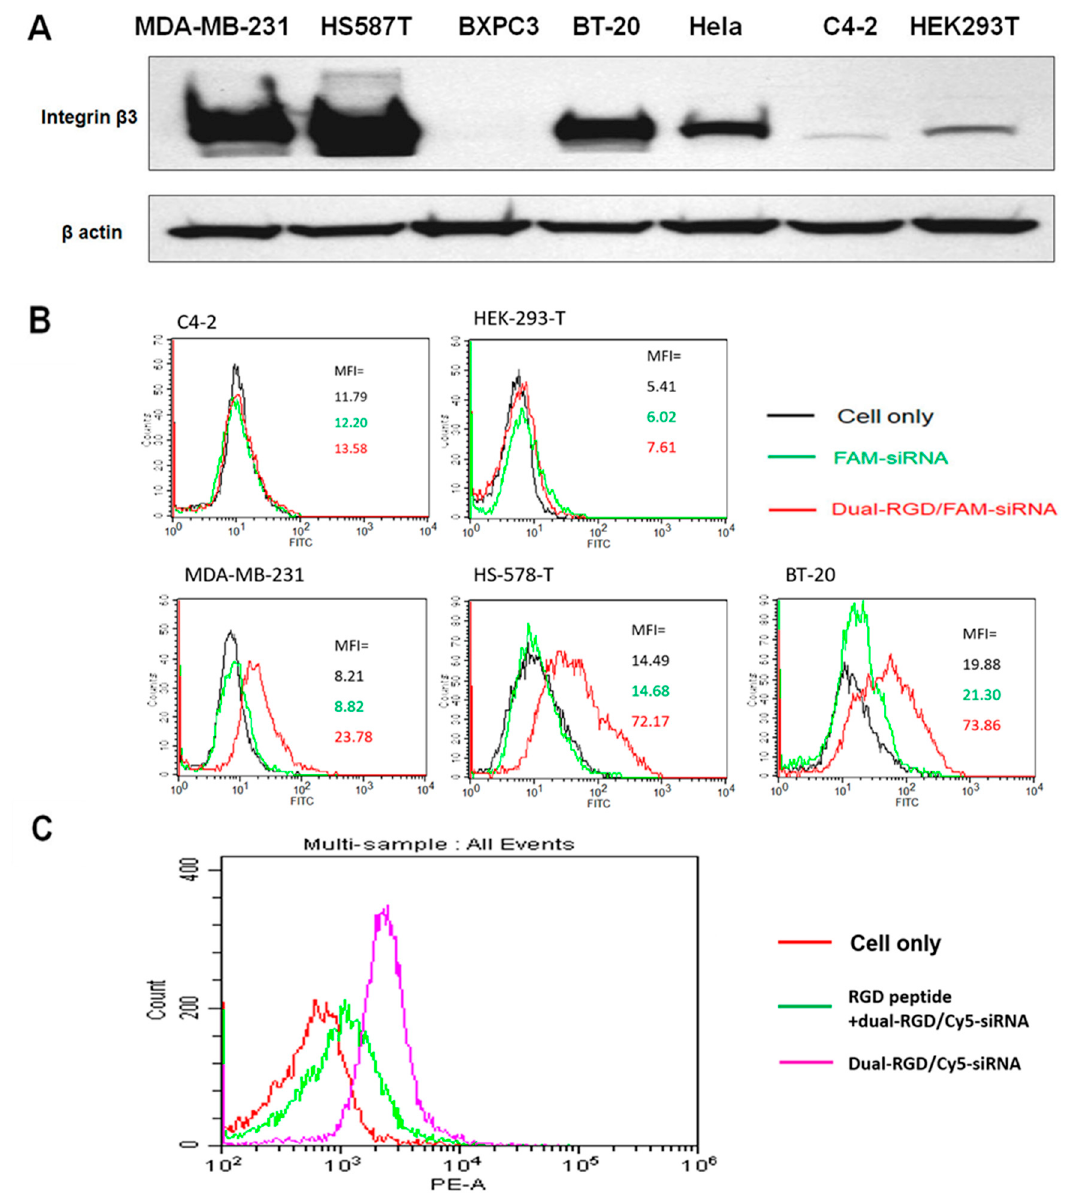
Figure 3. Integrin α v β 3 binding specificity. ( A ) Detection of integrin β 3 expression levels in cell lines by Western blot. ( B ) Evaluation of dual-RGD cell type-specific binding by flow cytometry. FAM-siRNA/dual-RGD or FAM-siRNA only was incubated with formalin-fixed cell lines at 37 °C for 1 h, and the binding specificity of dual-RGD was detected by flow cytometry. ( C ) Competitive assay. Fixed cell lines were first treated with free RGD peptide, and then Cy5-siRNA/dual-RGD complexes were added to the cells. The binding intensity was detected by flow cytometry.